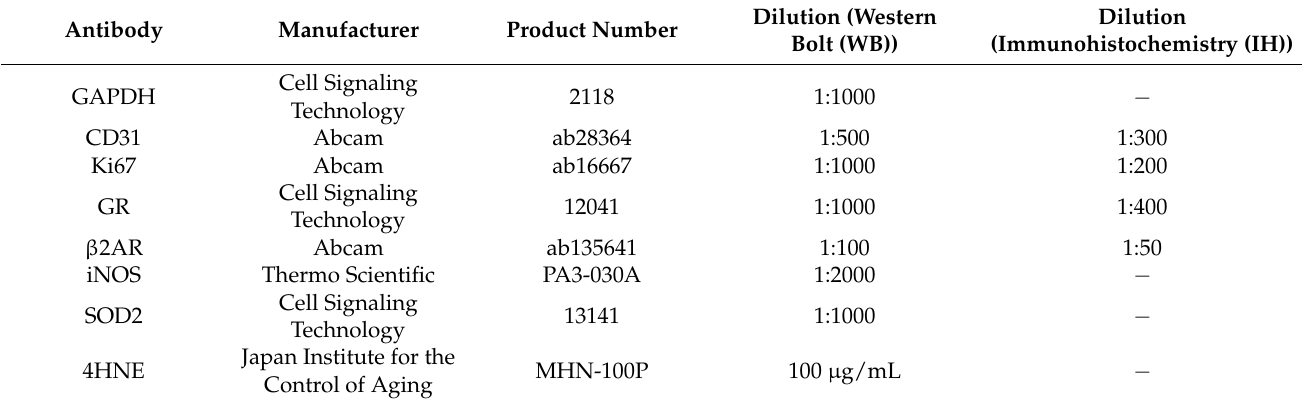
Table 1. Antibodies used for Western blot and